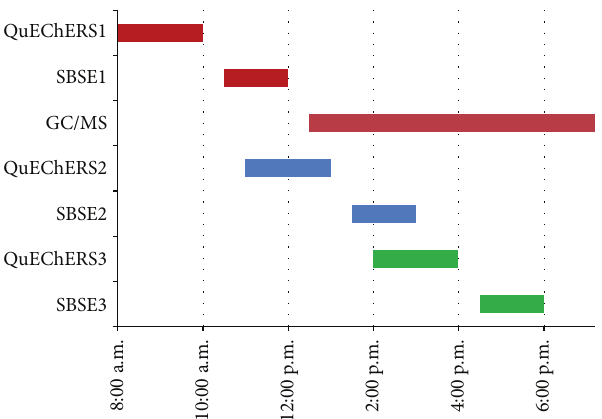
SBSE3QuEChERS3SBSE2QuEChERS2GC/MSSBSE1QuEChERS1 Figure 3: Flowchart demonstrating high throughput application of QuEChERS/SBSE method with one technician completing about 60 samples per